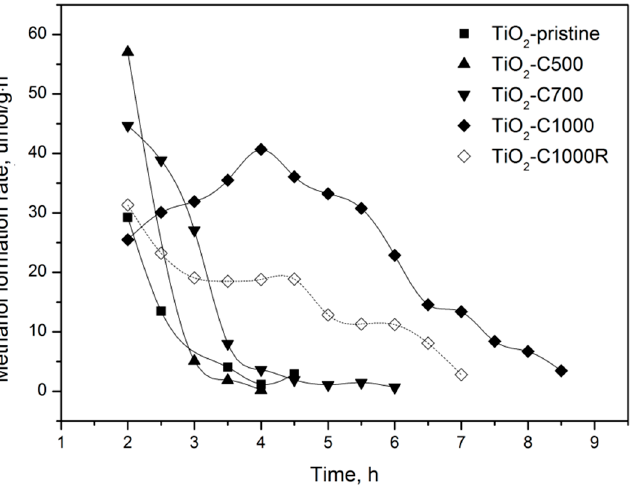
Figure 4. The photocatalytic activity of TiO 2 samples under UV–VIS irradiation as a function of reaction time on stream at 30 °C.